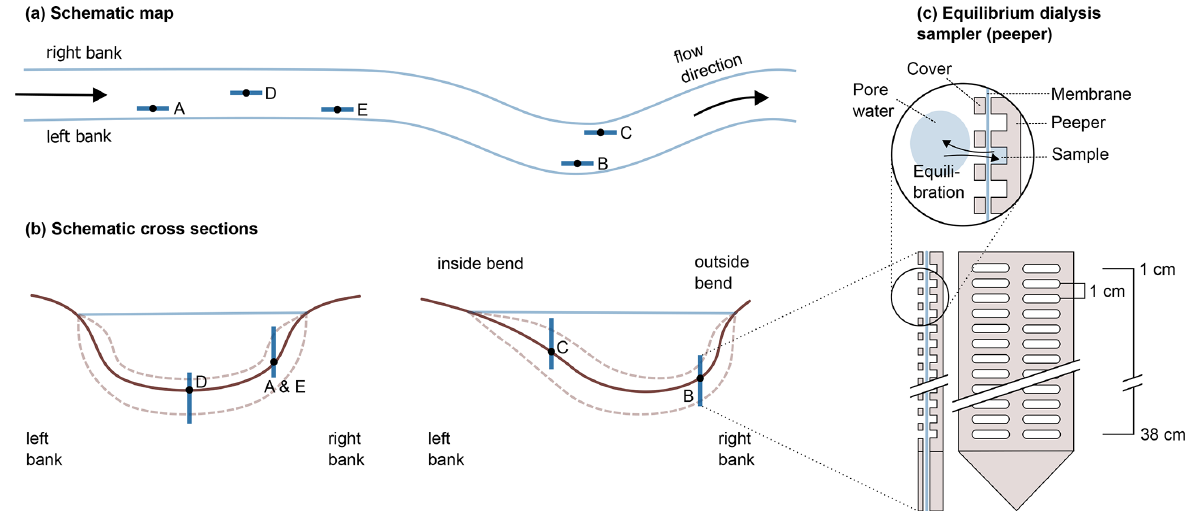
Figure 1. Schematic representation of the five sampling sites along the river (a) and across the riverbed (b) . In panel (c) , the sampler is schematically drawn, modified after Teasdale et al. (1995) (top: detail, bottom left: side view, bottom right: front view; for clarity, only 12 of the 38 chambers are